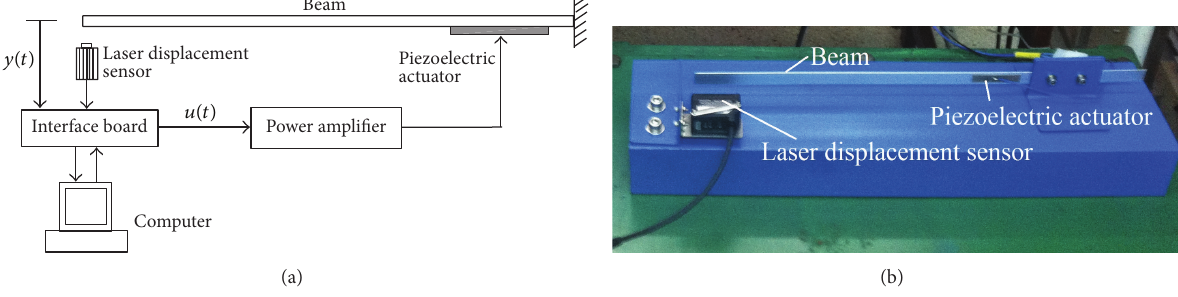
Figure 2: Experimental system: (a) schematic, (b) photograph.